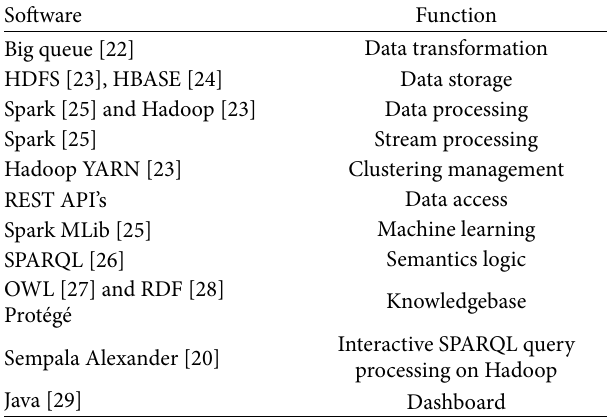
Table 2: The software packages used in the framework and its